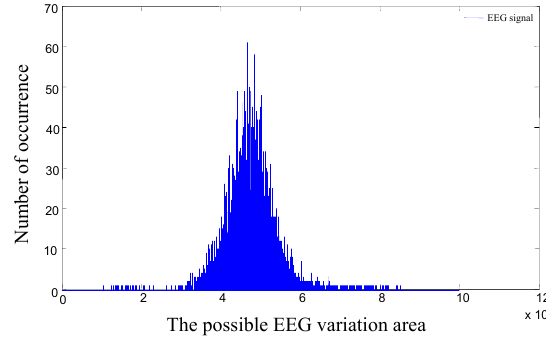
Fig. 5: Histograms of EEG samples captured by channel 1.